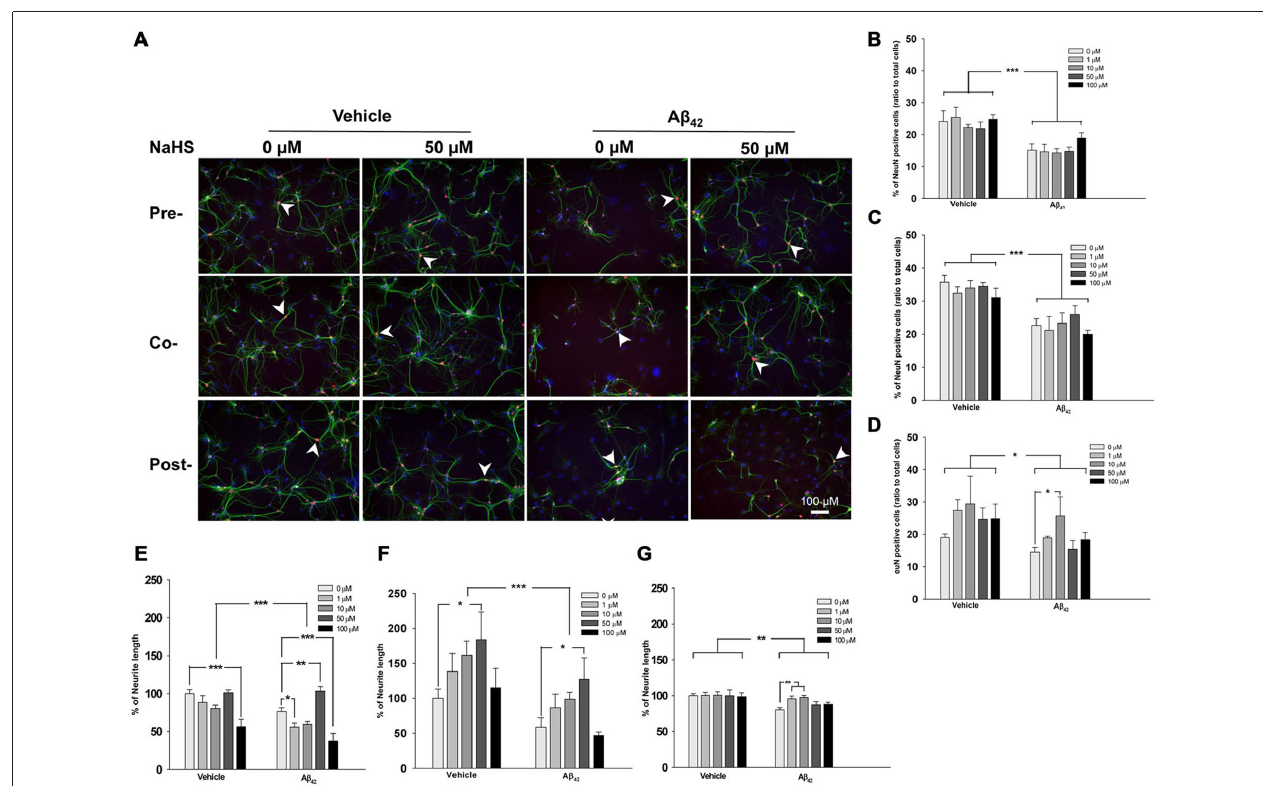
FIGURE 2 | Timing and doses of the NaHS treatments in mouse hippocampal primary neuronal cultures incubated with oligomeric A β 42 . (A) Representative immunofluorescence images of primary cultures stained for NeuN (red), MAP2 (green) and DAPI (blue). Scale bar: 100 µ M. (B–D) Quantification of the percentage of mature neurons relative to all cells in oligomeric A β 42 -treated primary cultures that also received pre-, co-, and post-treatment with NaHS. (E–G) Quantification of neurite length in oligomeric A β 42 -treated primary cultures that also received pre-, co-, and post-treatment with NaHS. The arrowheads indicate positive staining ( n = 3 per group). Data are expressed as the mean ± SEM. ∗ p < 0.05; ∗∗ p < 0.01; ∗∗∗ p <